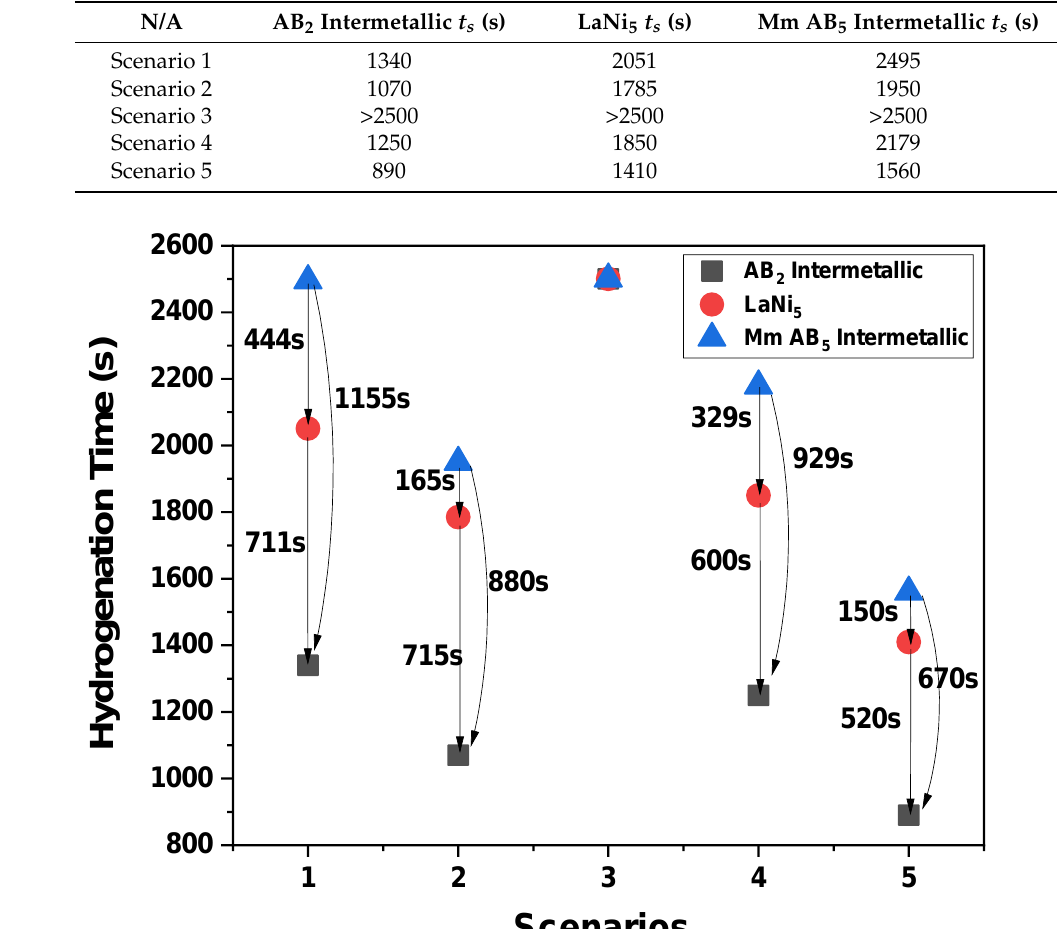
Table 3. Charging time of the materials studied for all the thermal management scenarios.